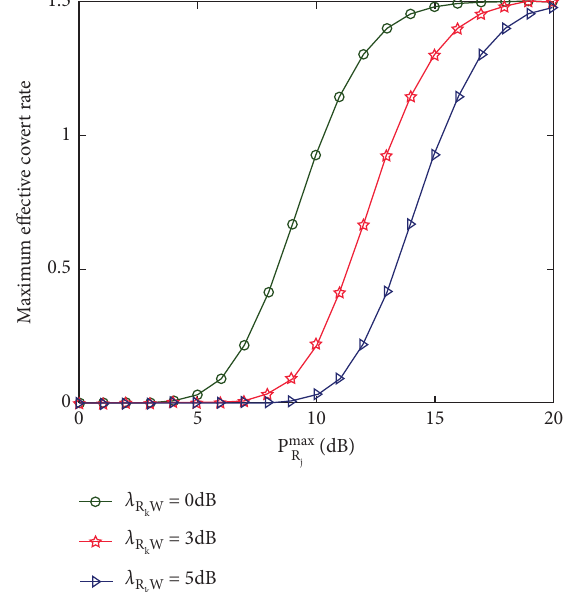
R k with dif- Figure 15: Maximum effective covert rate versus P value of σ 2 B , where R � 1 . 5, | h R